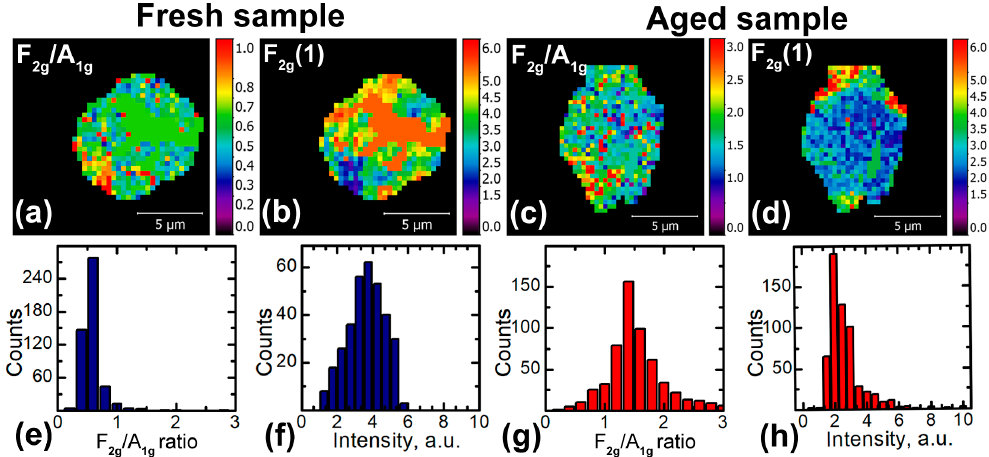
Figure 3. Mapping of the ( a , c ) ratio between F 2g /A 1g peak intensities ( b , d ) F 2g (1) peak intensity in the active ionic particles of ( a , b ) fresh and ( c , d ) aged LMO cathodes; ( e – h ) histograms of the signal corresponding to maps ( a – d ). Completely lithiated state: Li 0.9 Mn 2 O 4 (0% SOC).